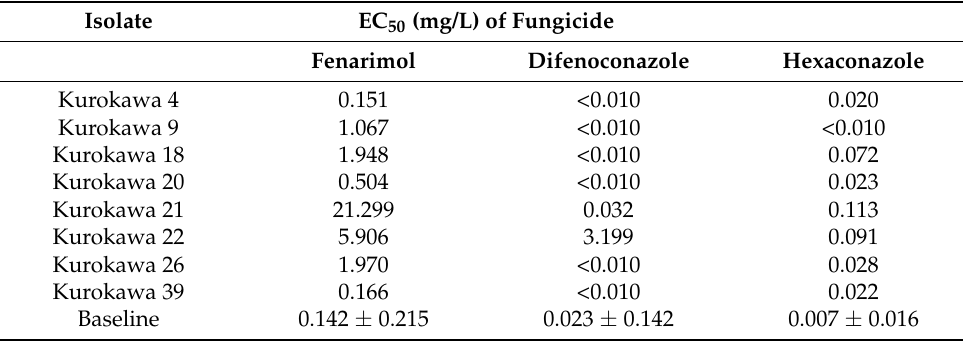
Table 5. Sensitivity of Venturia nashicola isolates to the three DMI fungicides in culture. Isolate EC 50 (mg/L) of Fungicide Fenarimol